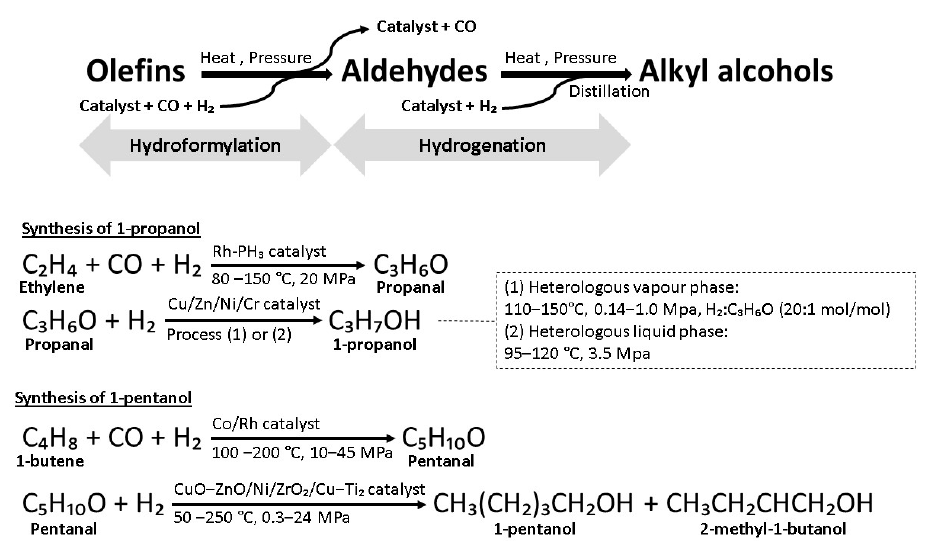
Figure 4. Oxo synthesis of alkyl alcohols [62,97,99].